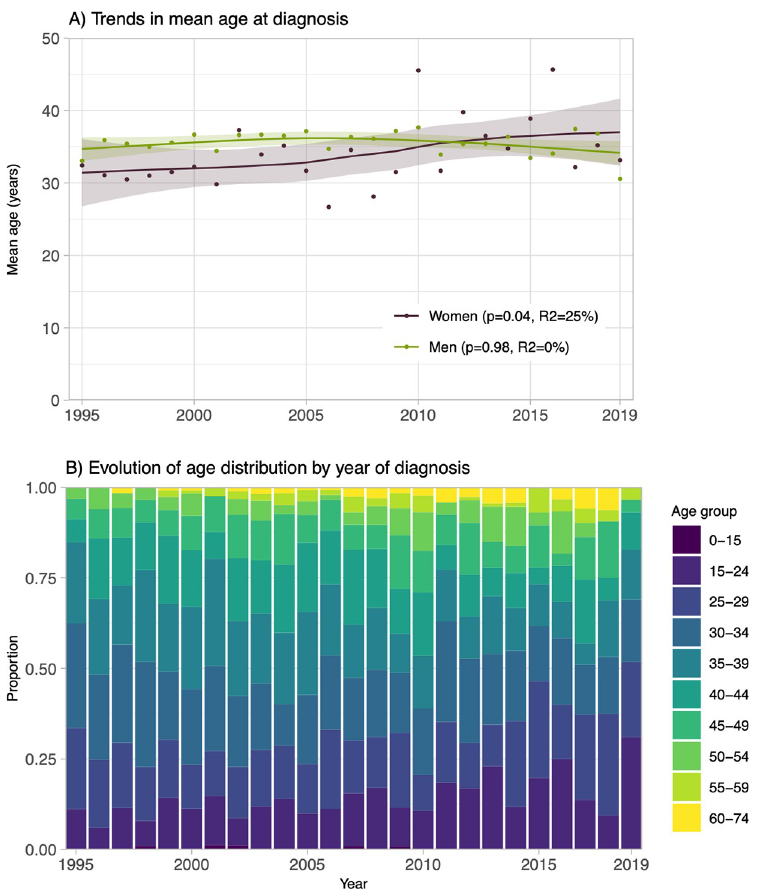
Fig 3. Evolution of age at HIV diagnosis among participants to the HIV-positive cohort at the Clinique médicale l’Actuel in Montre´al (Canada) over 1995–2019 (n = 2,612). Panel A displays the mean age at diagnosis stratified by gender for each calendar year. Trends are displayed using local linear fitting and a degree of smoothing of 0.75. Linear time trends (p-values) were assessed by the mean of t-tests within univariate meta-regressions where the year of diagnosis was input as a continuous predictor variable. Panel B shows the underlying age distributions, categorized in ten groups, for both genders